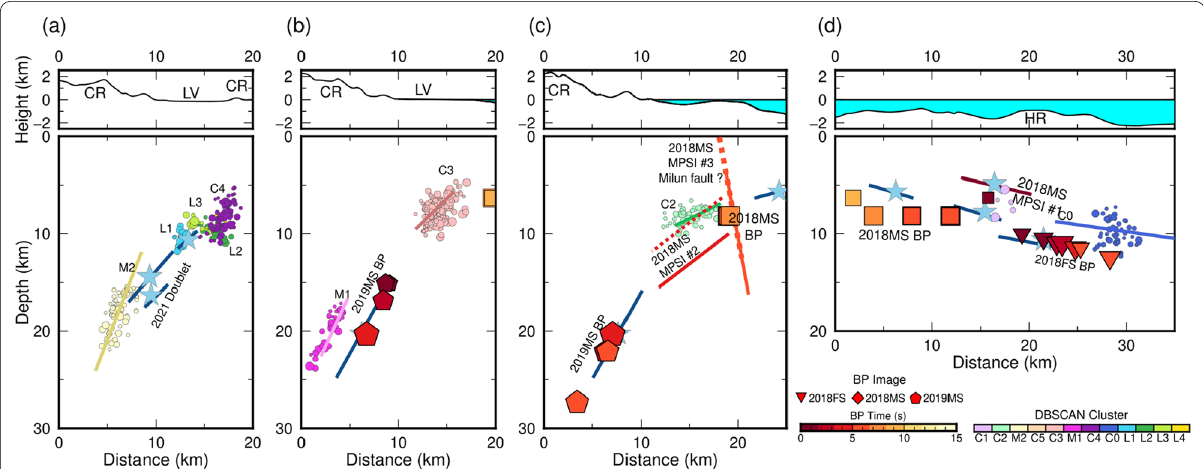
Fig. 7 Cross‑sections of profiles presented in Fig. 6 (same symbols and colors): (top) topography and (bottom) seismogenic structures derived from empirical ruptures and PCA (note dashed lines mark potential shallower locations of the subevents’ rupture due to uncertainties regarding the centroid